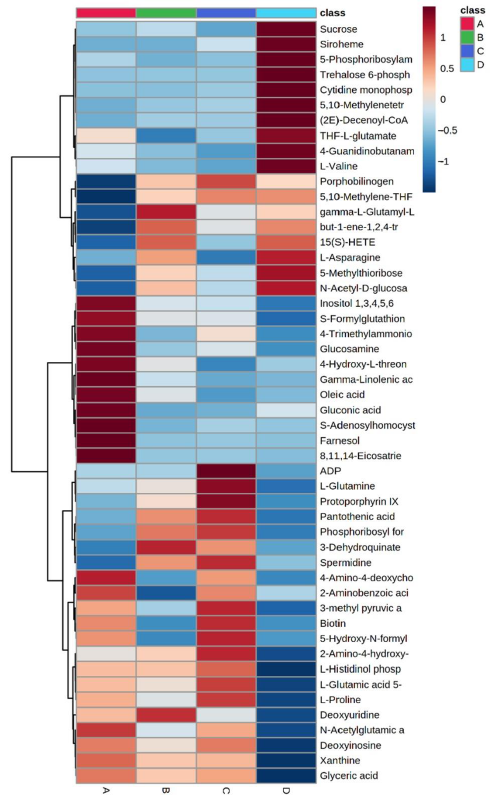
Figure 2. Heatmap using of the 50 most significant metabolites from the ANOVA test. In the heatmap columns, red color indicates higher relative levels of metabolites, whereas the blue color suggests a minor content of them.